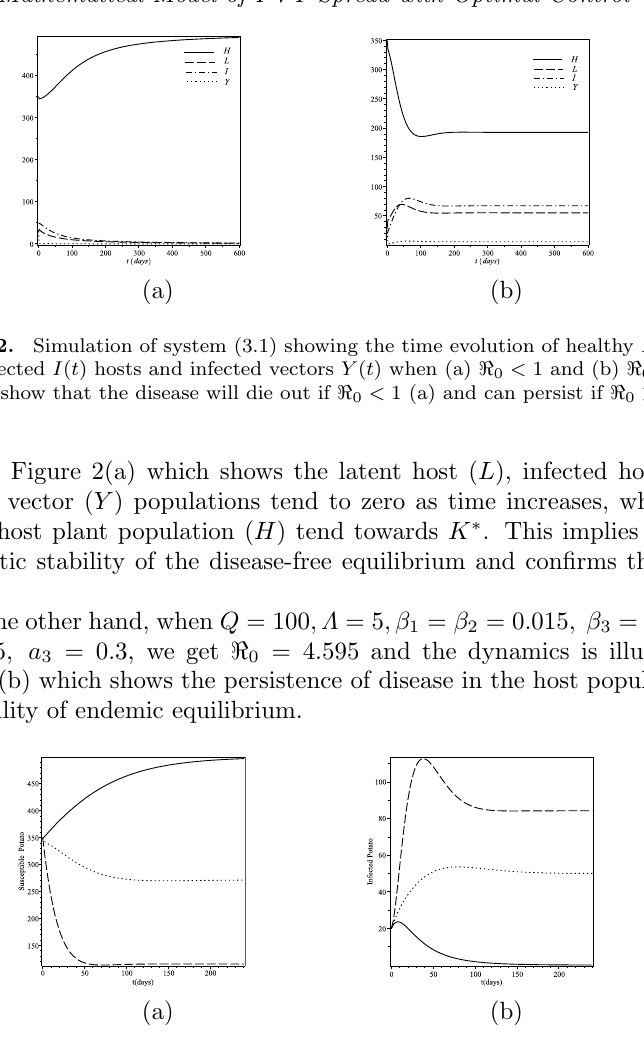
Figure 3. Plots showing effects of density of the barrier plant Q and its associated parameters on the dynamics of healthy H ( t ) and infected I ( t ) plant populations. The solid curves are when Q = 200 , a 1 = 0 . 3 , a 2 = 0 . 3 ,a 3 = 0 . 5 ,β 3 = 0 . 05, the dotted are when Q = 100 ,a 1 = a 2 = 0 . 5 ,a 3 = 0 . 4 ,β 3 = 0 . 03, and the dashed are when Q = 0 ,a 1 = a 2 =